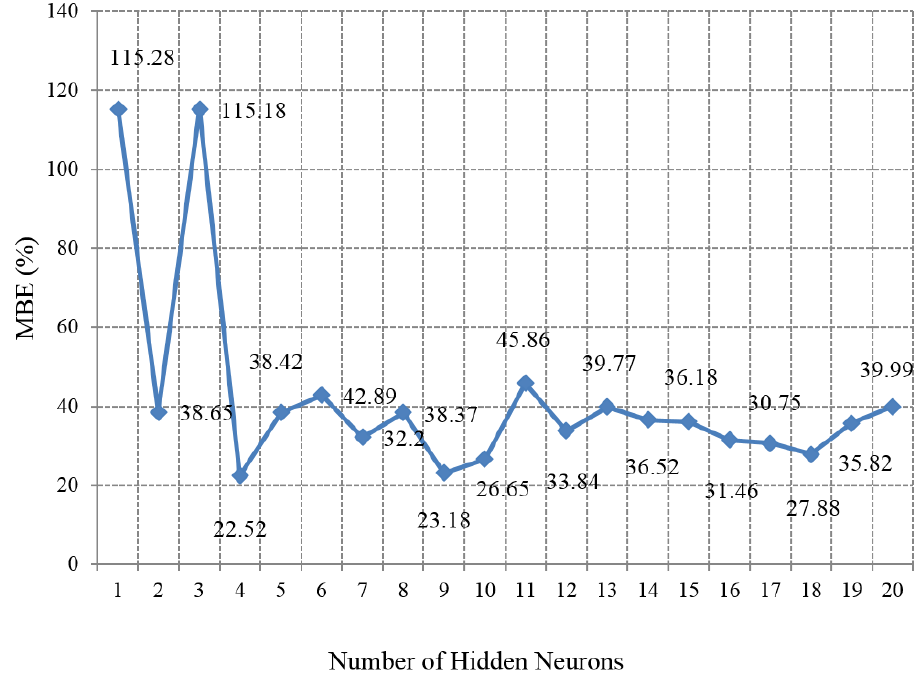
Figure 12. MBE (mean biased error) values by number of hidden